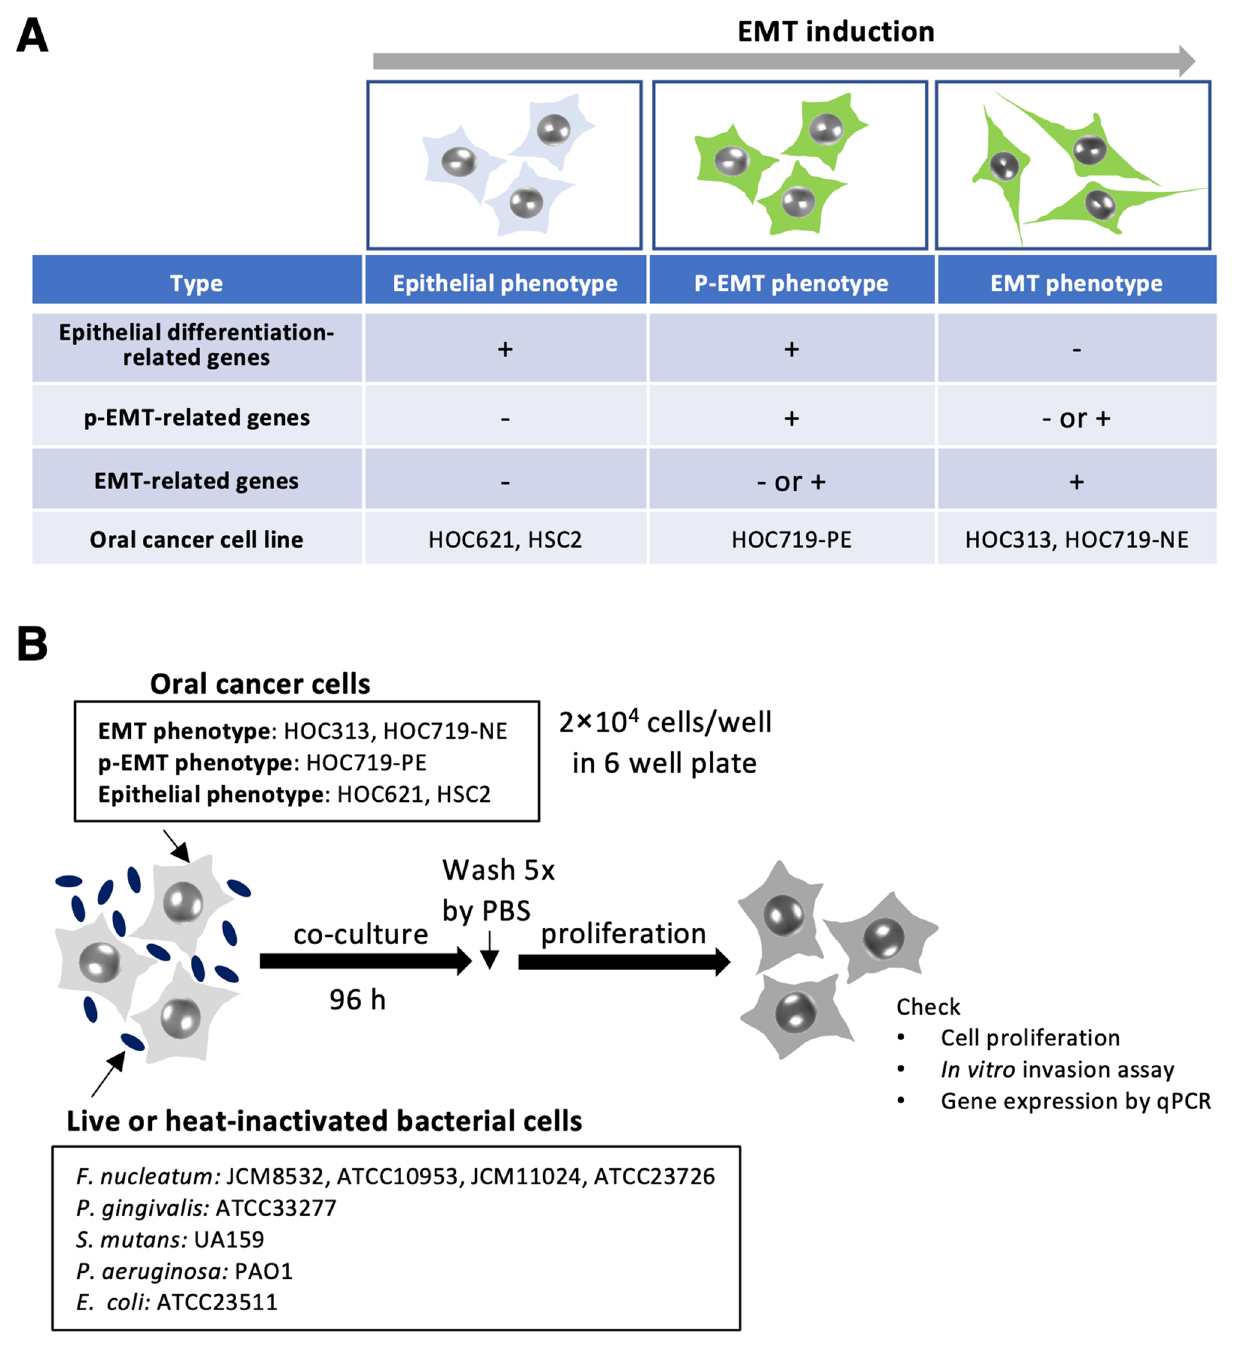
Figure 1. Strategies of this study. ( A ) The list of OSCC cell lines that showing their properties; epithelial phenotype, p-EMT phenotype, and EMT phenotype. The properties were defined by gene expression 18 . ( B ) Study flow of Fusobacterium nucleatum treatment to OSCC cells for analyses including the cell proliferation, in vitro invasion assay and gene expression. Four subspecies of F. nucleatum and 5 OSCC cell lines were used. After OSCC was co-cultured with F. nucleatum for 96 h and then washed by PBS five times. After washing, cells were used for the